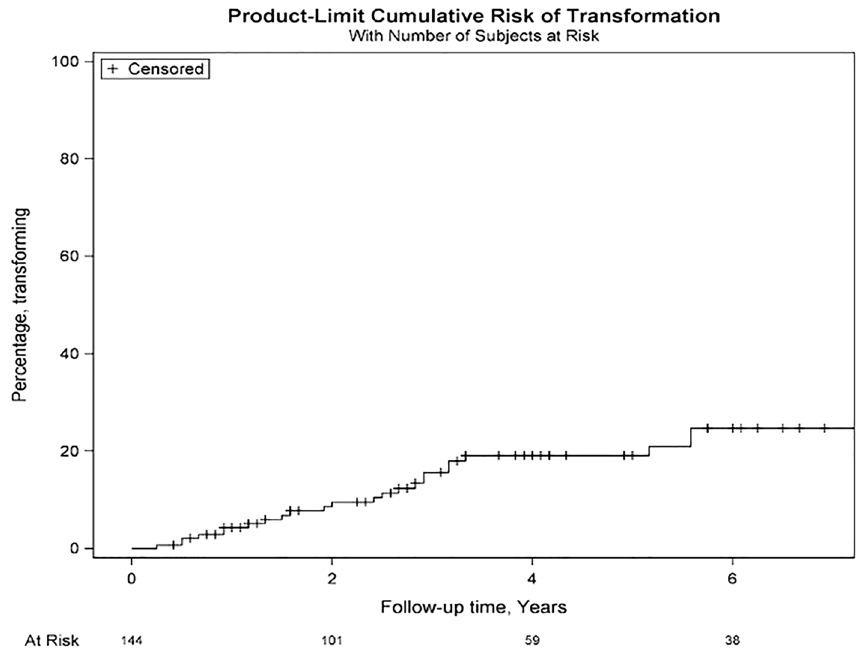
Figure 1. Cumulative probability curve of transformation of hypervascular nodules to hepatocellular carcinoma (entire cohort).